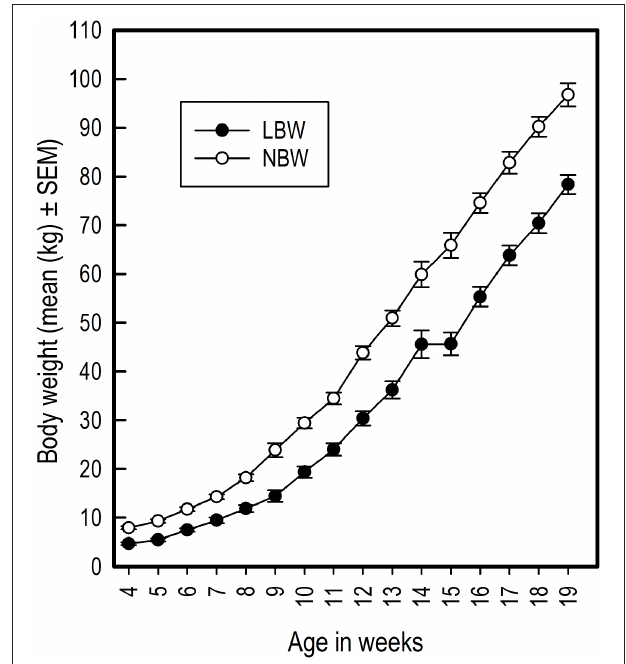
FIGURE 2 | Average body weight in kilograms of LBW and NBW pigs from weaning until the end of the experiment. For week 15, data from only ten LBW pigs was available, causing an appearance of lack of growth from week 14 to 15. This is an artifact due to missing data.